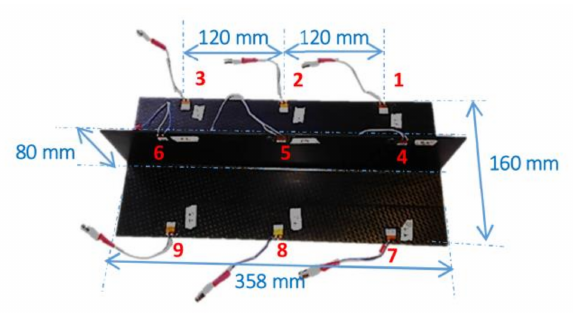
Figure 1. Geometry of the CFRP T-joint sample with attached PZT transducers.